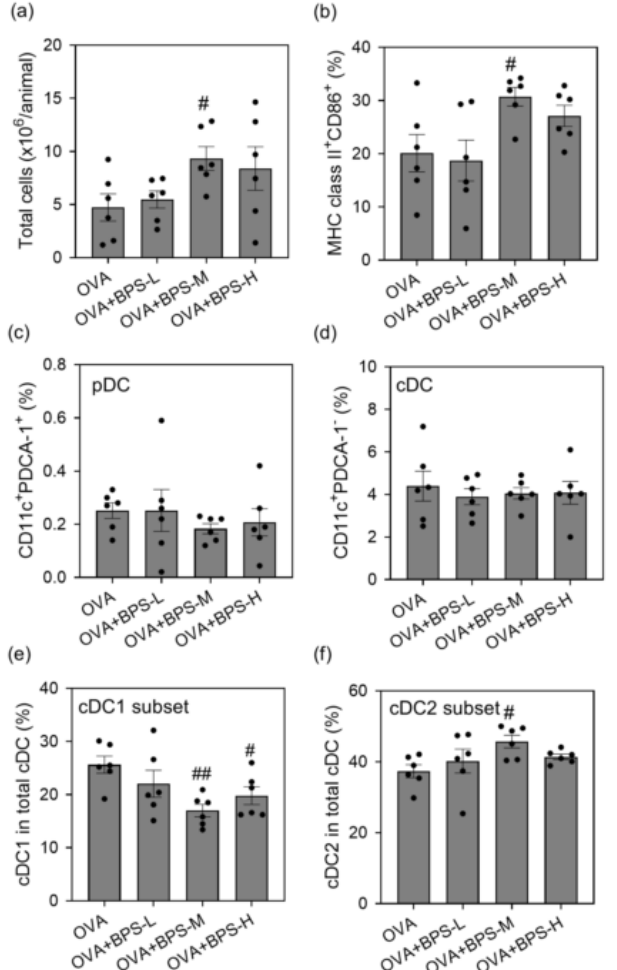
Figure 8. Expression of cell number and cell surface molecules in MLNs. Cell surface molecule expression was determined via fluorescence-activated cell sorting analysis 48 h after the final OVA intratracheal administration. ( a ) Total cell number. ( b ) Percentage of MHC class II + CD86 + cells. ( c ) Percentage of pDC. ( d ) Percentage of cDC. ( e ) Percentage of cDC1 in total cDC. ( f ) Percentage of cDC2 in total cDC. Data are expressed as means ± SE for 6 animals per group. # p < 0.05 vs. OVA group, ## p < 0.01 vs. OVA group. cDC, conventional dendritic cells; MLN, mediastinal lymph node; OVA, ovalbumin; pDC, plasmacytoid dendritic cells; SE, standard error.